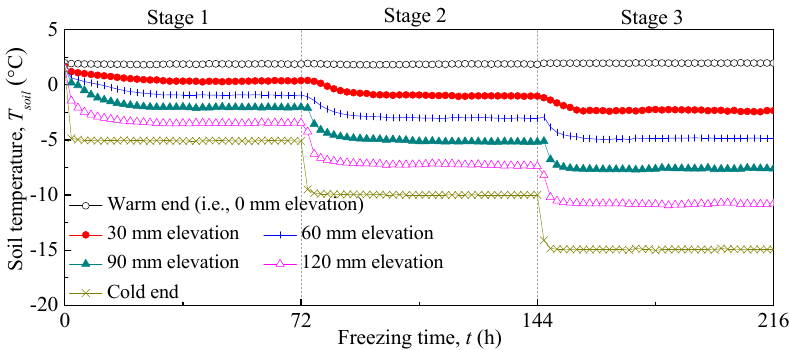
Figure 6. Internal temperature of soil samples at different heights in test FT1.